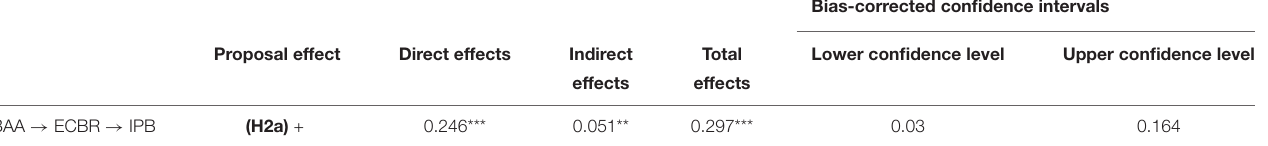
TABLE 5 | Direct, indirect, and total effects